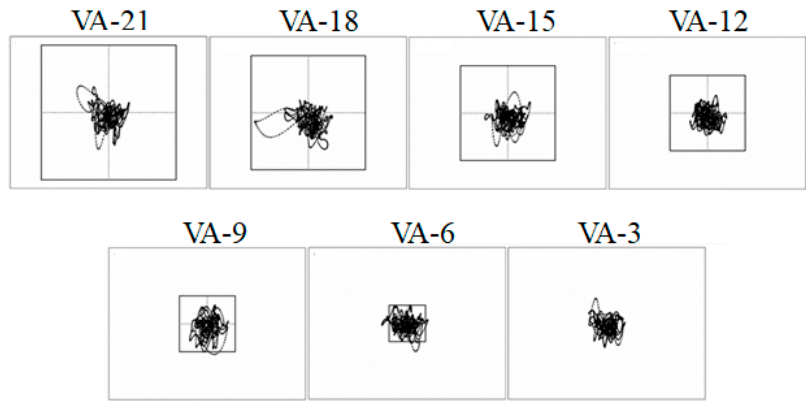
Figure 5. A schematic of the square boxes representing the visual angle areas in which the head projection vector had to be maintained. The angles subtended by the box horizontally and vertically were varied in each condition from 21 ◦ to 3 ◦ of visual angle with 3 degree decrements. An example of one participant’s head movement is illustrated (note that the participant did not see the trace of the path; they only saw the movement of the dot from the projection vector). Adapted from Lim et al. [46].